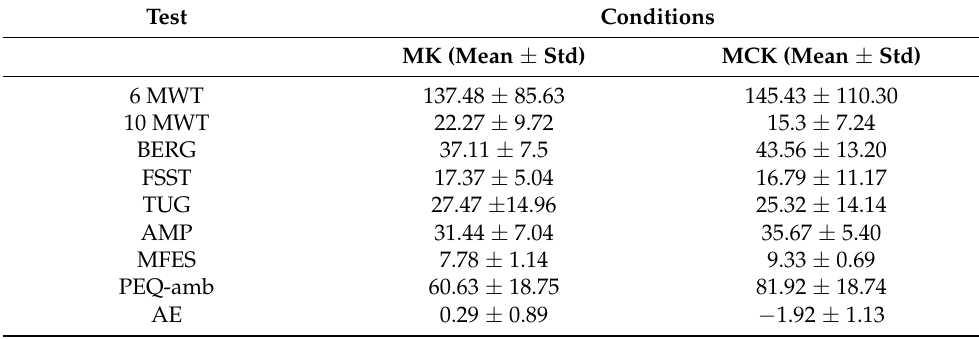
Table 2. Means and standard deviations (std) of test results for each condition.